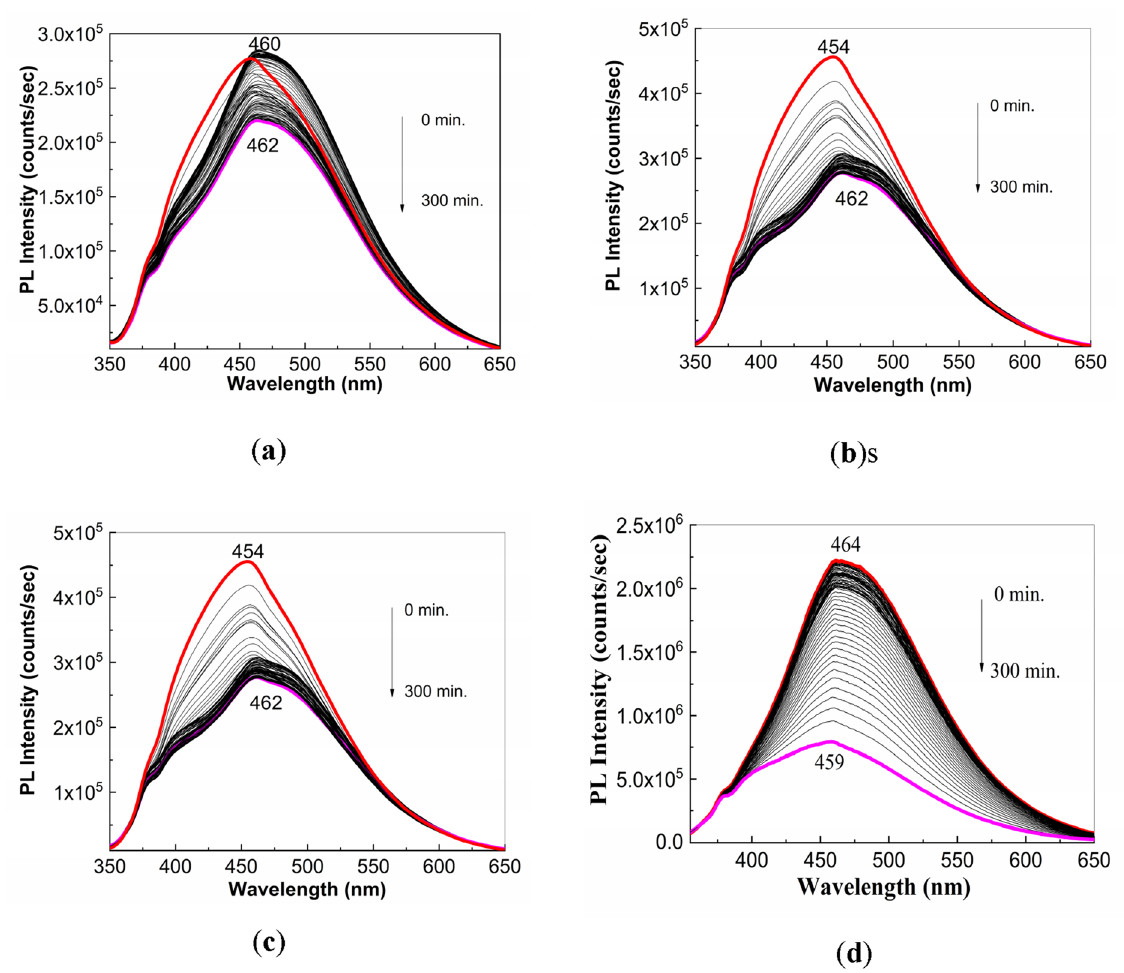
Figure 9. PL spectra of PS ( 1 ; 2 mg/ml) interacted with NaOH (0.3 M) when the volumetric ratio is equal to 2:1 ( a ), 1.5:1.5 ( b ) and 1:2 ( c ). Figure d shows the PL spectra of the Controloc ( 4 ) drug (having PS concentration of 2 mg/ml) interacted with the NaOH 0.3 M, when the volumetric ratio of the two solutions is of 2:1 and the sample is exposed to UV light, for 300 min. The red and magenta curves correspond to PL spectra of samples, prior and after to 300 min od UV light exposure, while the black curves show PL spectra successively